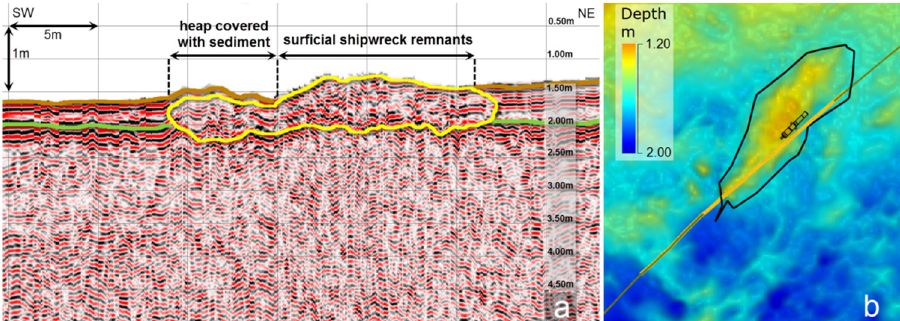
Figure 8. Interpretation of a sub-bottom seismic section along the main wreck mound. ( a ) The shipwreck remnants are outlined by yellow colour and are laying on a geological horizon (marked in green) c. 0.5 m below the seafloor. High amplitude acoustic reflectors extend 6 m southwest of the wreck mound. These reflectors and a correlated magnetic anomaly (Figure 6), indicate distribution of buried wreck-related material under the annotated sediment heap. ( b ) Seafloor bathymetry at current epoch, as well as geographic view of the corresponding boat transect (shown in brown) over the wreck mound (outlined in